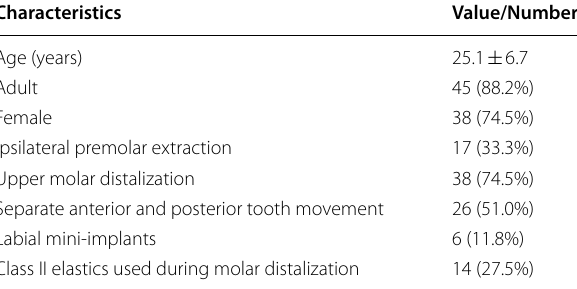
Table 3 Intraoperator agreement